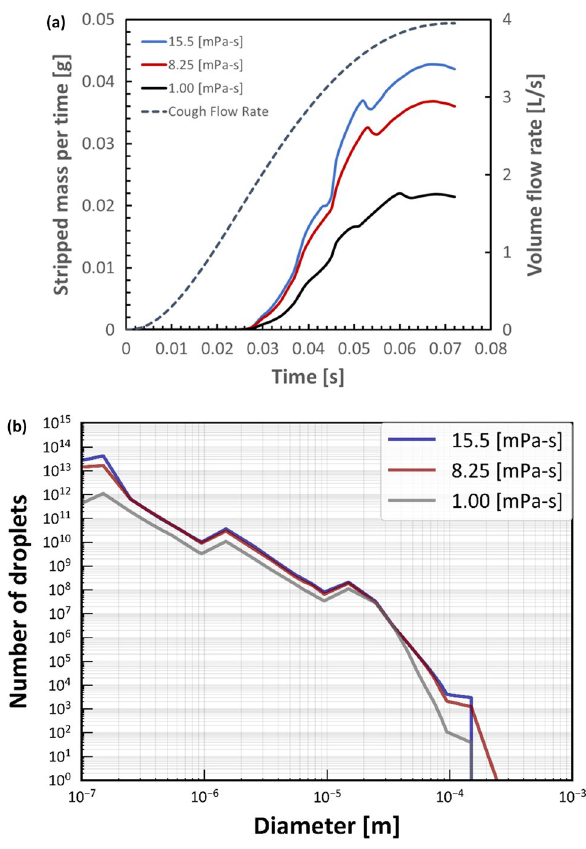
Figure 8. Particle stripping with different mucous viscosities. ( a ) Stripped particle mass of the film for each time step. ( b ) Particle size distribution of droplets